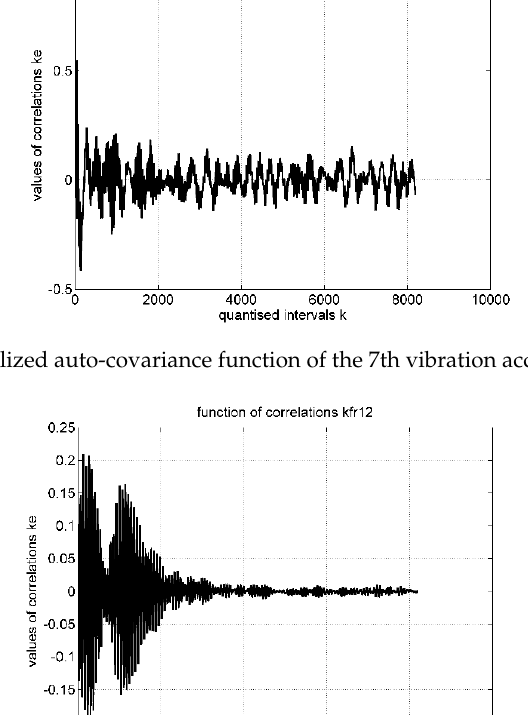
Figure 9. Normalized inter-covariance function of the 1st and 6th vibration accelerations vectors. Figure 10. Normalized inter-covariance function of the 2nd and 5th vibration accelerations vectors.